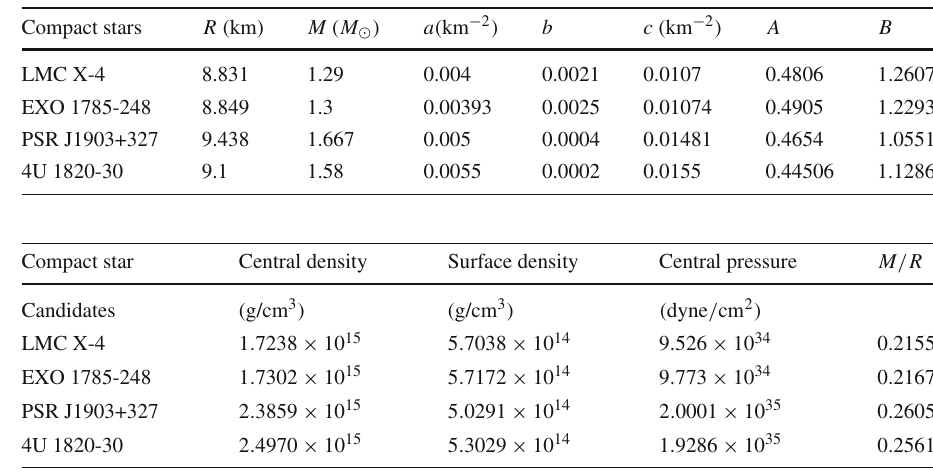
Compact stars R (km)